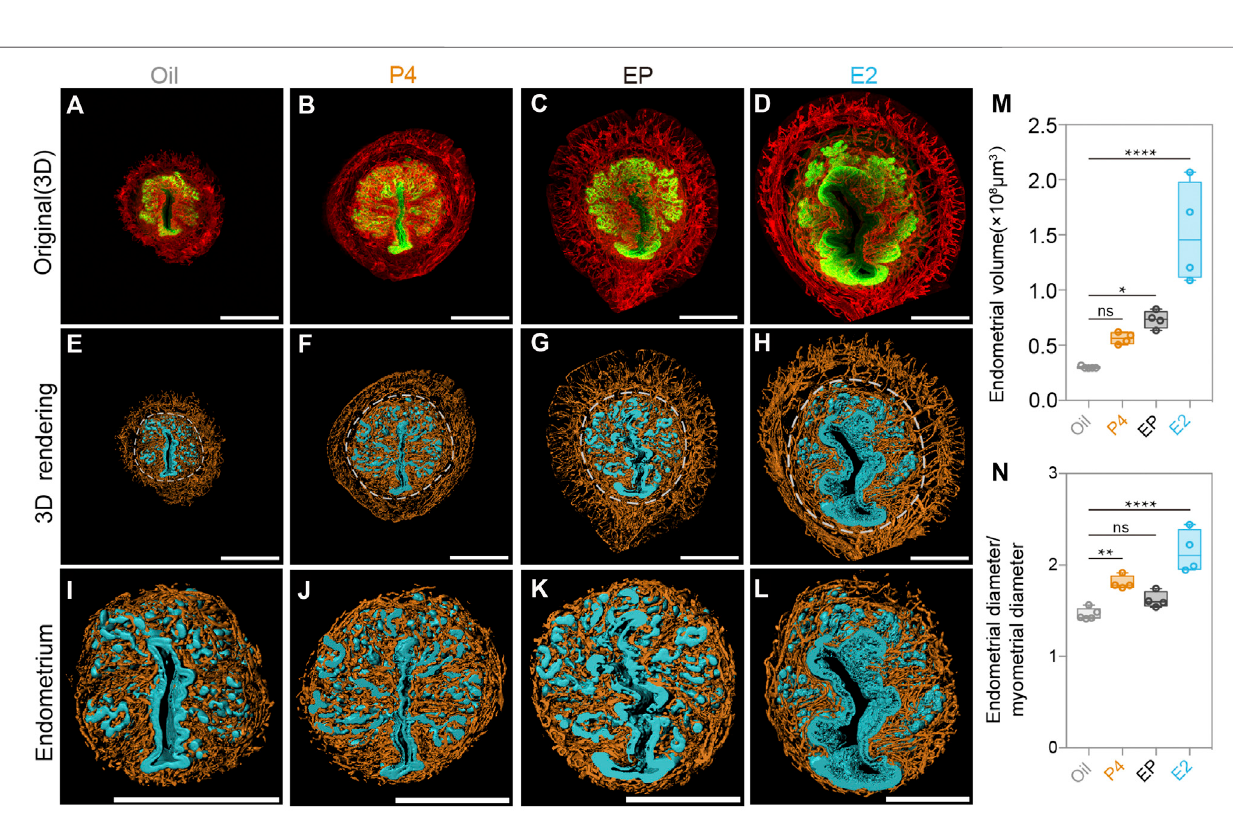
Frontiers in Cell and Developmental Biology |